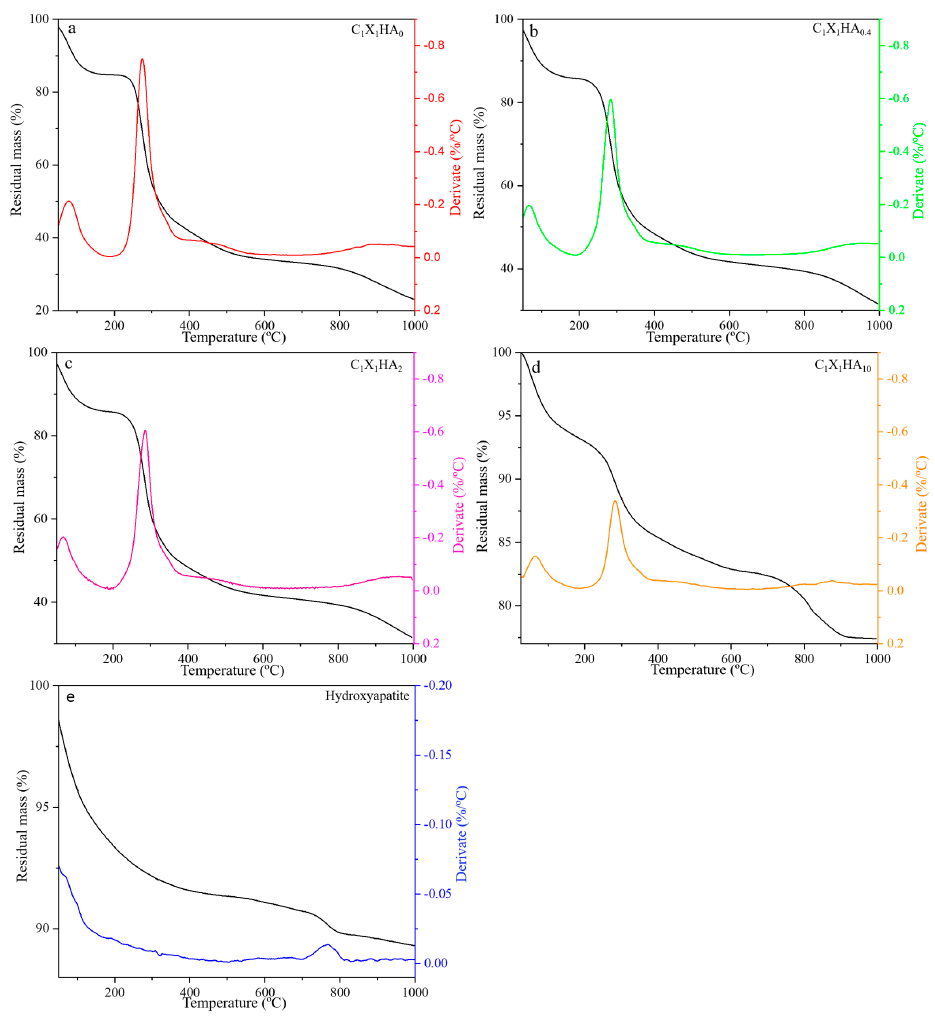
Figure 3. Thermogravimetric analysis and its derivative for the membrane formulations: ( a ) C 1 X 1 HA 0 ; ( b ) C 1 X 1 HA 0.4 ; ( c ) C 1 X 1 HA 2 ; ( d ) C 1 X 1 HA 10 ; and ( e ) pristine hydroxyapatite.